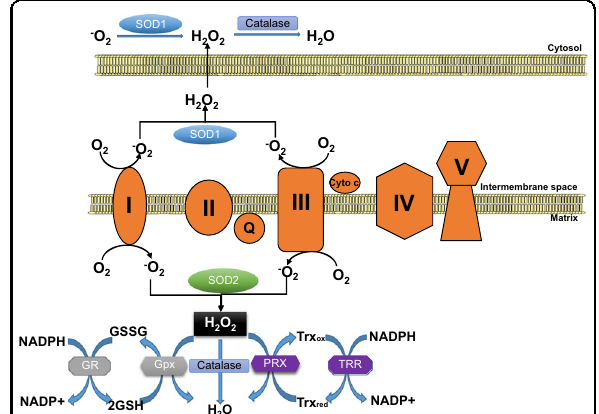
Fig. 2 ROS scavenging systems in the mitochondria. Superoxide (O 2 − ) is produced at respiratory chain complexes I and III and is dismutated by SOD1 (intermembrane space and cytosol) and SOD2 (matrix) to generate hydrogen peroxide (H 2 O 2 ). Catalase, localized to both the cytosol and the mitochondrial matrix, converts H 2 O 2 into H 2 O. Mitochondrial H 2 O 2 detoxi fi cation can also be catalyzed by mitochondria-localized glutathione peroxidases (Gpx1 and Gpx4) and peroxiredoxins (PRX3 and PRX5). Gpxs oxidize glutathione (GSH) into GSSG, and reduced glutathione is regenerated by glutathione reductase (GR) using the reducing equivalents of NADPH. PRXs oxidize thioredoxin (Trx, with Trx2 being mitochondria-localized), and the reduced Trx pool is regenerated by the NADPH-dependent action of thioredoxin reductase (TRR; with TRR2 localized to the mitochondrial